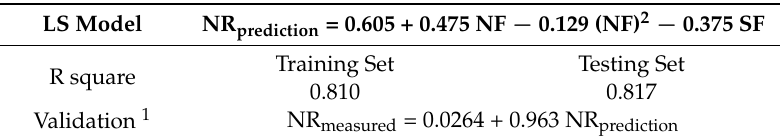
Table 4. Statistical model results for OP2.